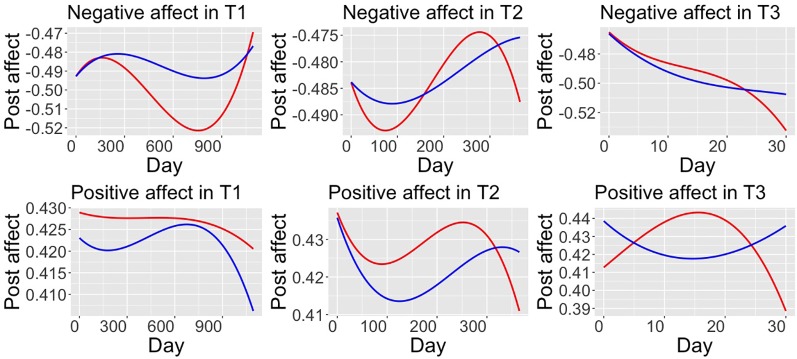
Affect patterns of the high symptoms and low symptoms group. Red lines, H-group; Blue lines, L-group. T1, three-year time window; T2, one-year time window; T3, 30-day time window. Figures of negative affect are negative up.